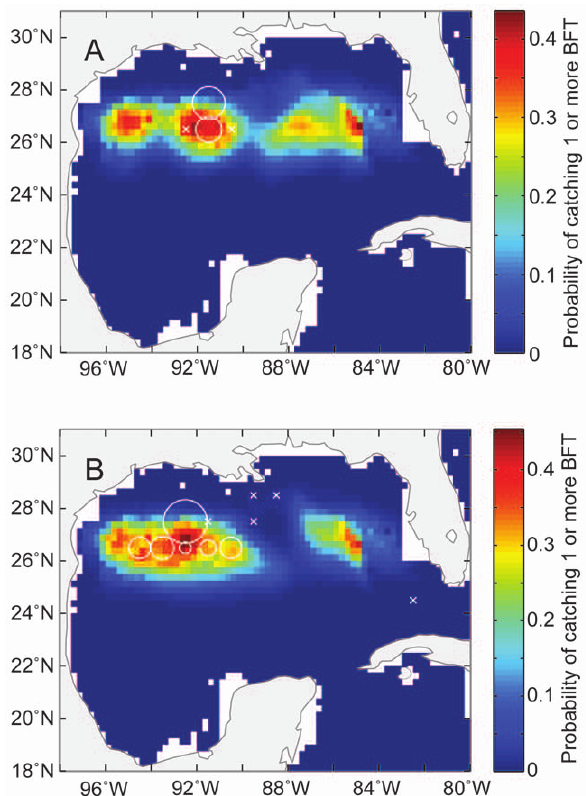
Figure 8. Expected probability of catching bluefin tuna. Colors indicate the expected probability of catching one or more bluefin tuna in the Gulf of Mexico on 15 May (A) 2002 and (B) 2005. Circles indicate actual relative bluefin tuna CPUE for May 2002 and 2005. Crosses indicate locations where at least one longline set was deployed but no fish were